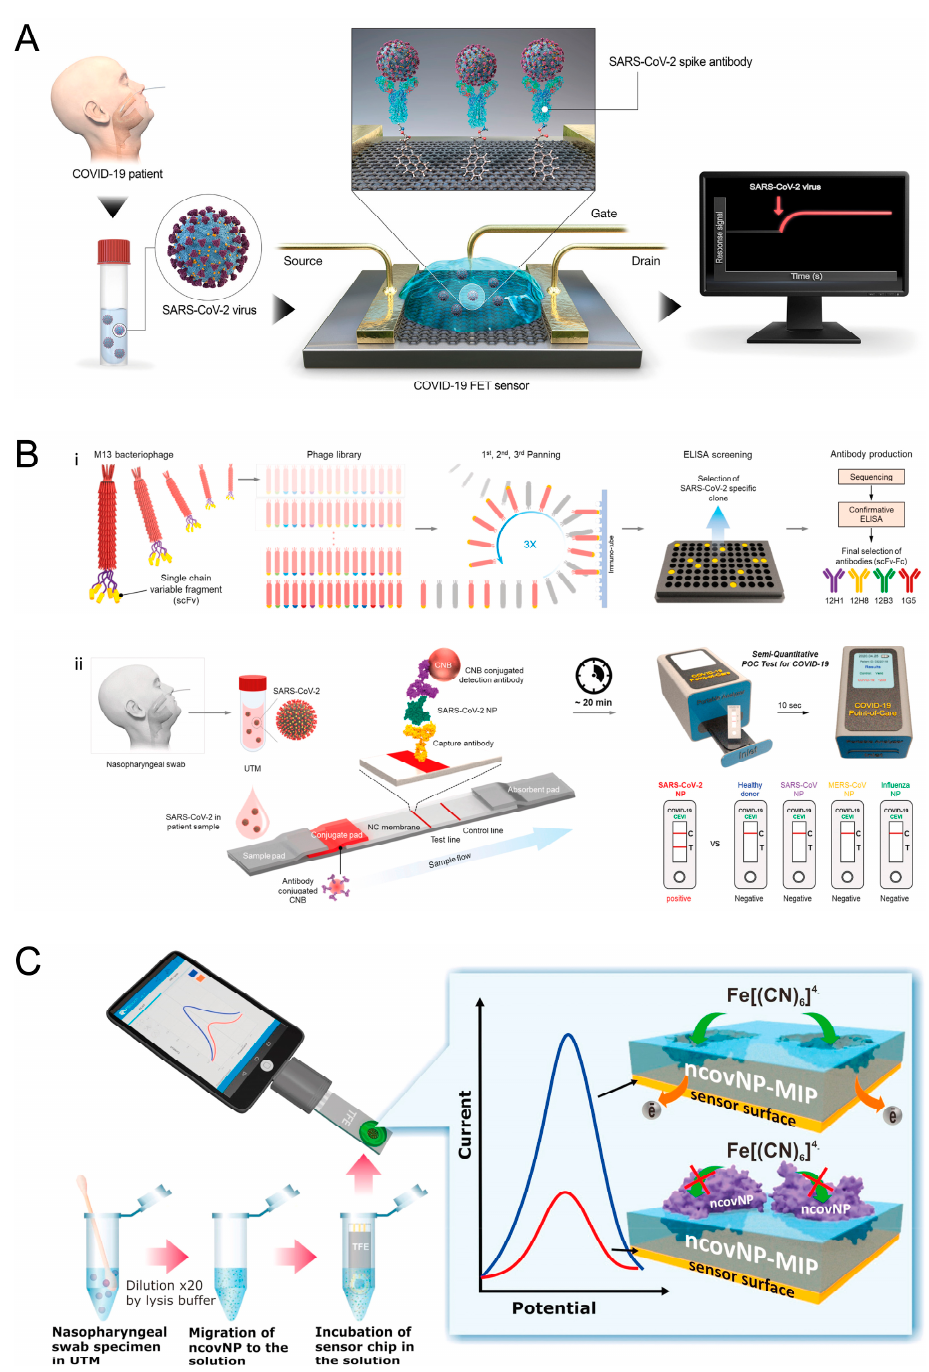
Figure 3. SARS-CoV-2 antigen detection in a nasopharyngeal swab. ( A ) S protein detection with